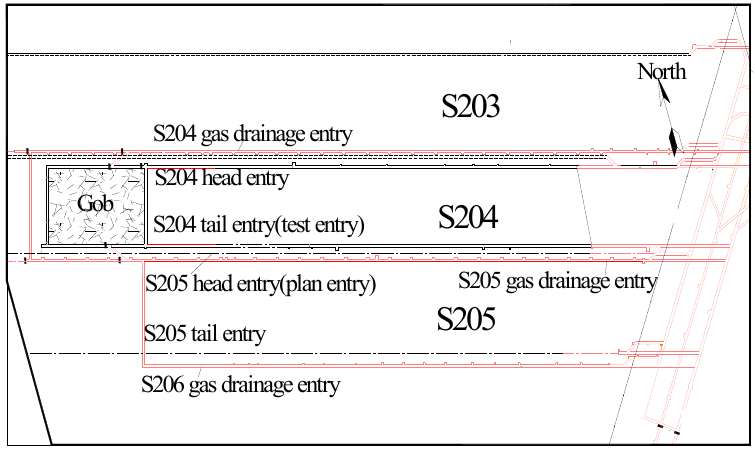
Figure 6. Three-dimensional schematic diagram of the FRME.